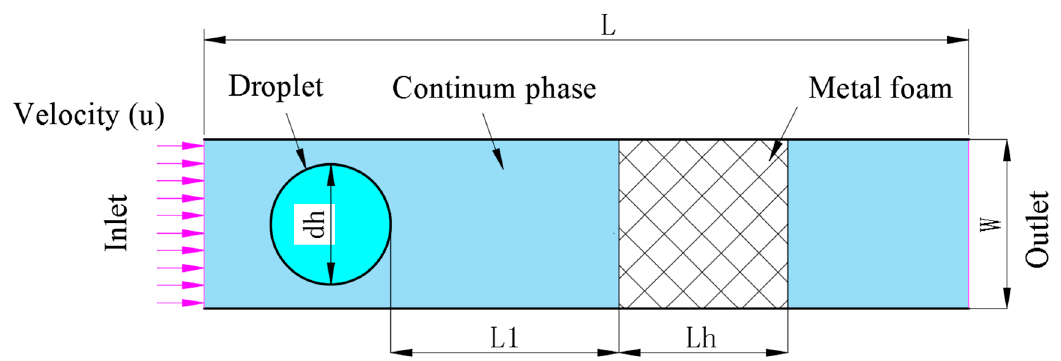
Figure 3. Schematic diagram of a droplet passing through metal foam in a computational domain of 500 (length) × 50 (width) × 50 (height) lattice cell and L1 of 175 lattice cell.